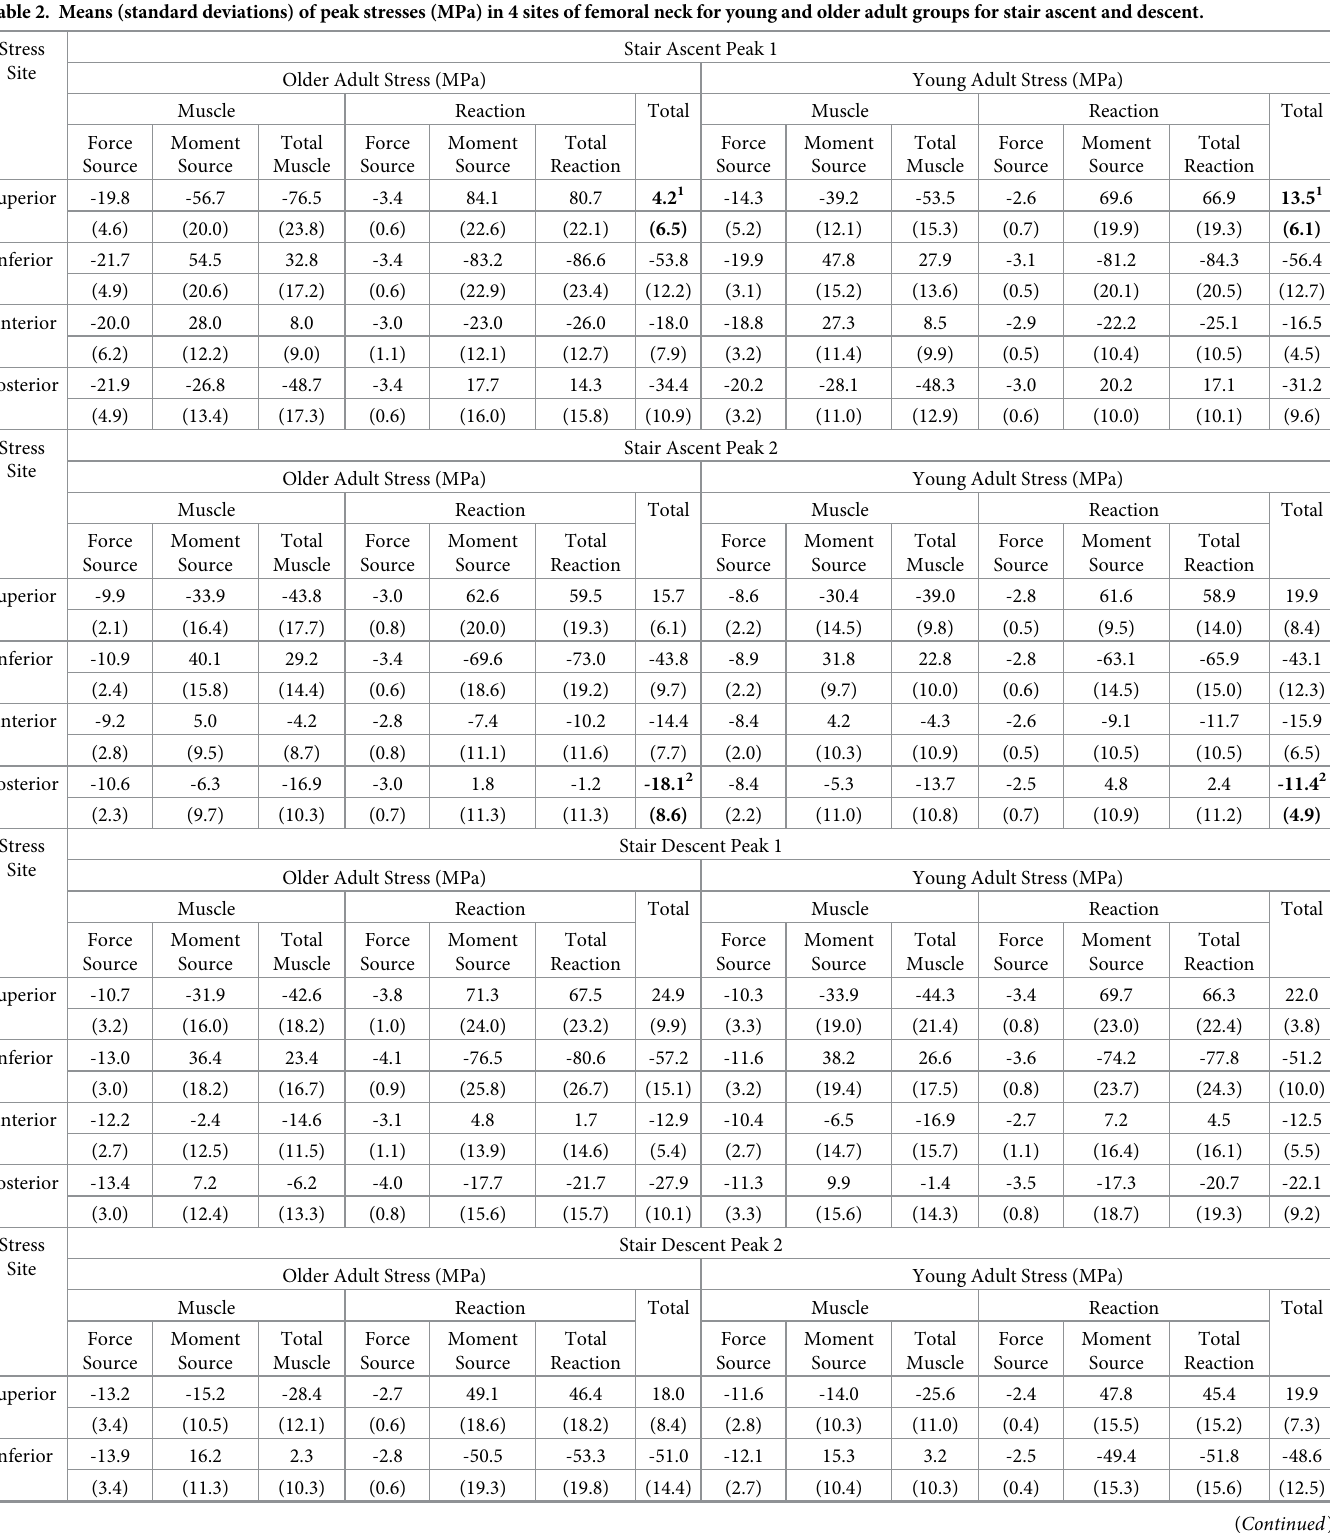
Table 2. Means (standard deviations) of peak stresses (MPa) in 4 sites of femoral neck for young and older adult groups for stair ascent and